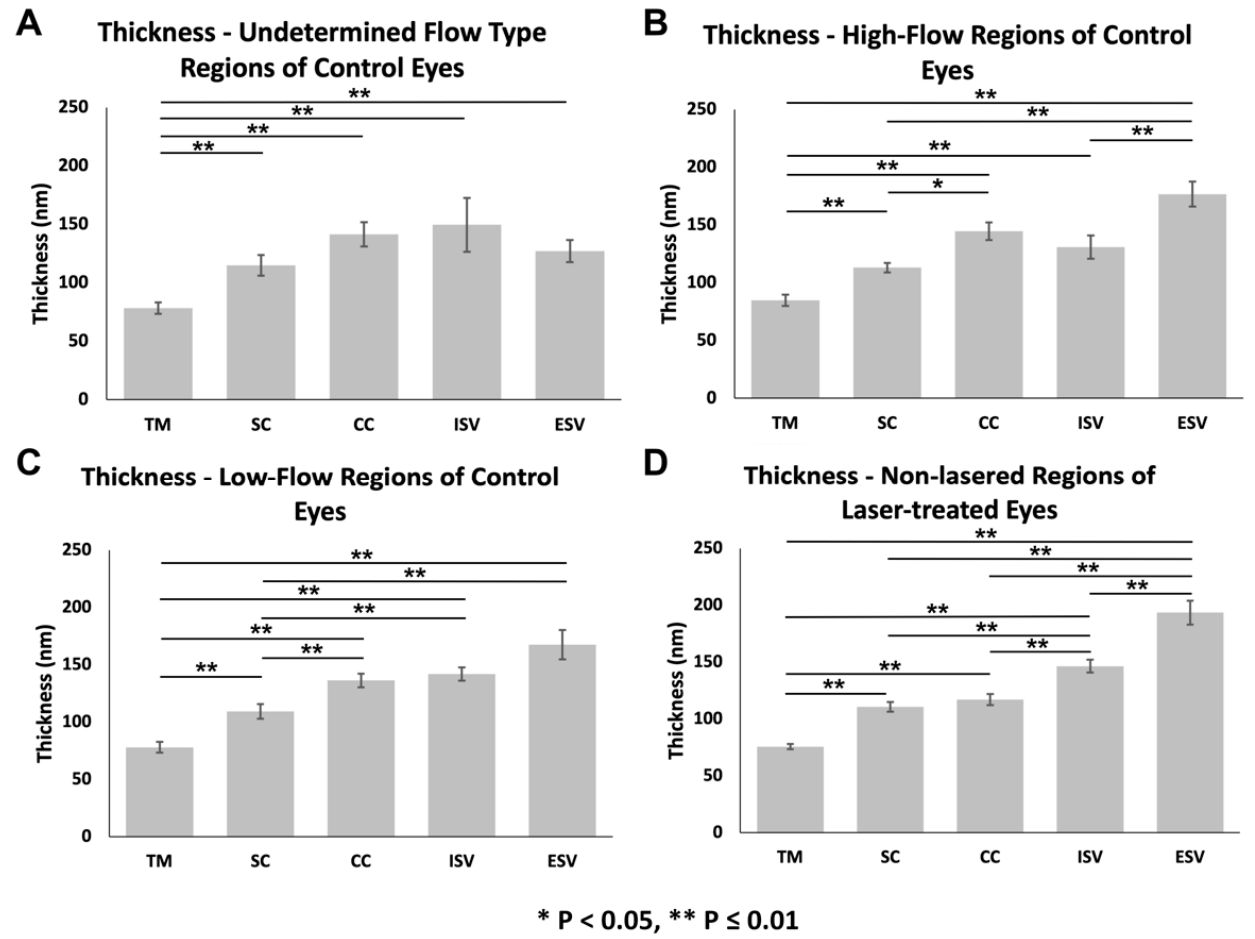
Figure 6. Glycocalyx thickness along the different locations of the outflow pathway by flow region. ( A ) Undetermined-flow type regions of control eyes (ANOVA, F = 13.99, p ≤ 0.01), ( B ) high-flow regions of control eyes (ANOVA, F = 26.45, p ≤ 0.01), ( C ) low-flow regions of control eyes (ANOVA, F = 31.57, p ≤ 0.01), and ( D ) non-lasered regions of laser-treated eyes (ANOVA, F = 117.81, p ≤ 0.01)